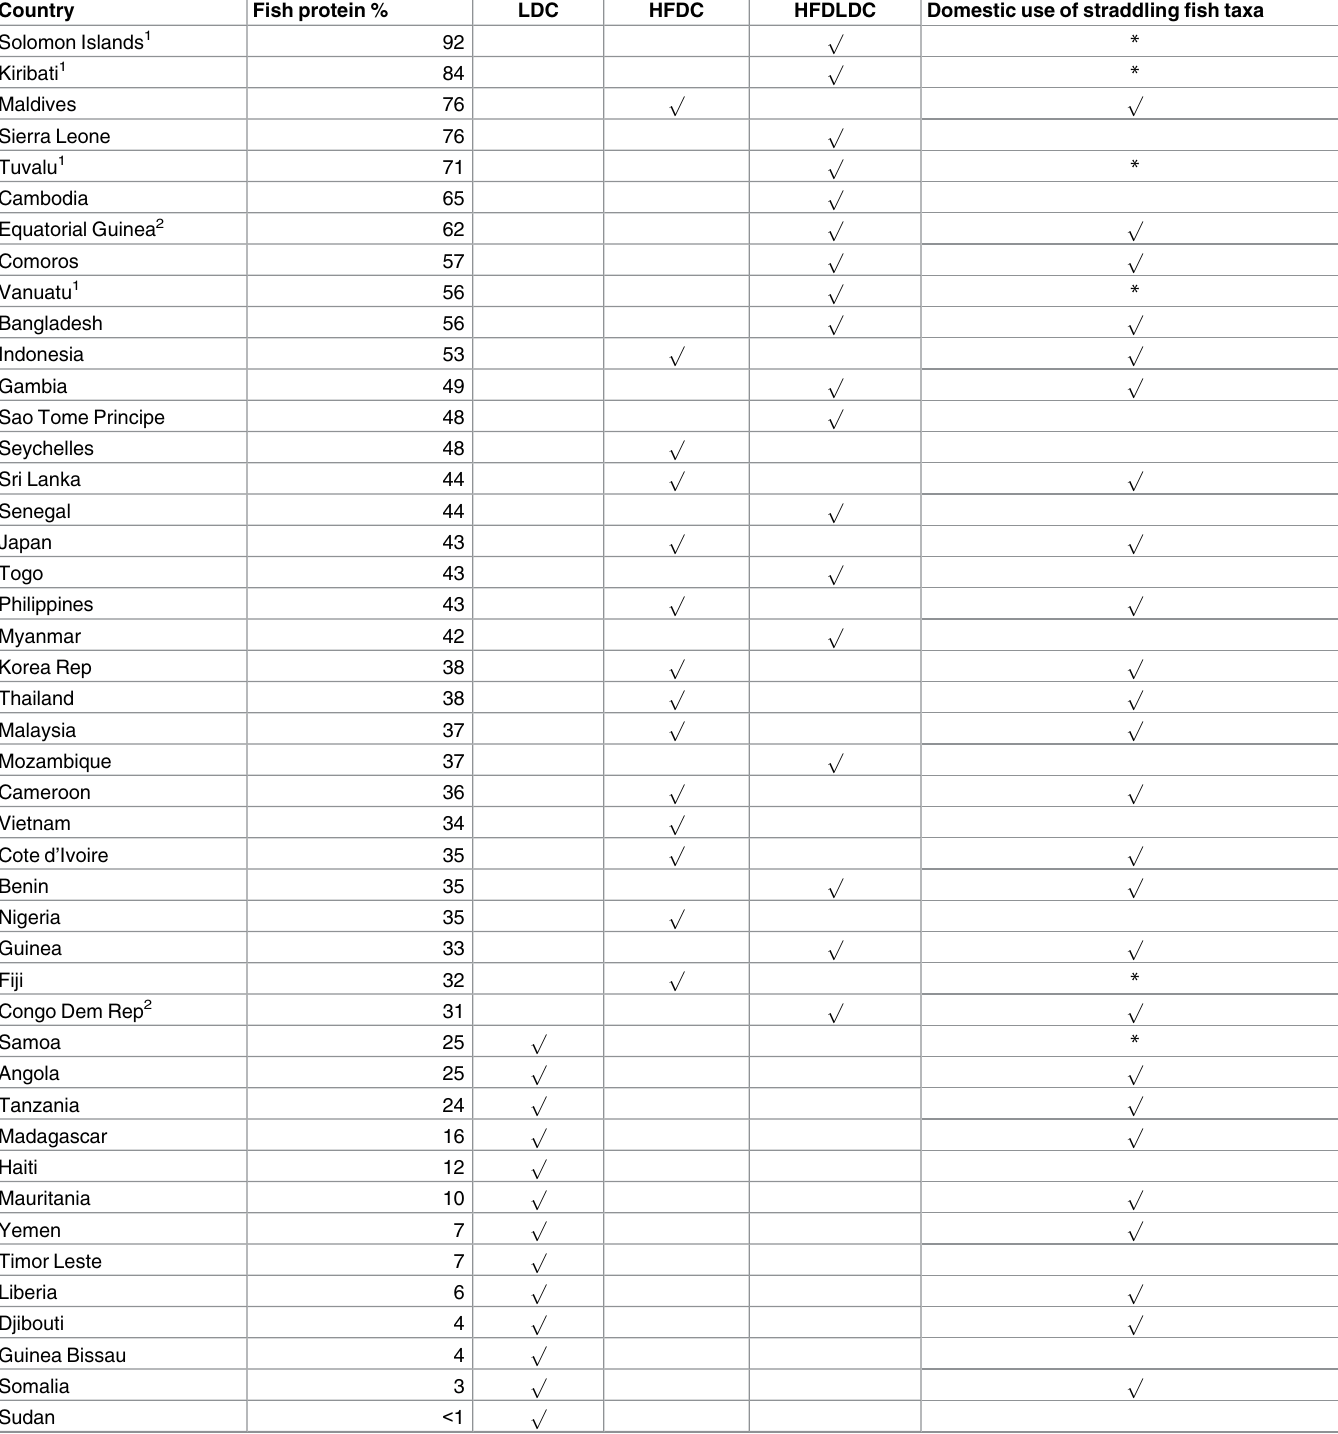
Table 1. Contribution (%) of fish to total animal protein supply and domestic use of straddling fish taxa in Least Developed Countries (LDC), High Fish Dependent countries (HFDC), and High Fish Dependent LDCs (HFDLDC). Countriesare listed in order of fish dependency. Country Fish protein % LDC HFDC HFDLDC Domestic use of straddling fish taxa Solomon Islands 1 92 Kiribati